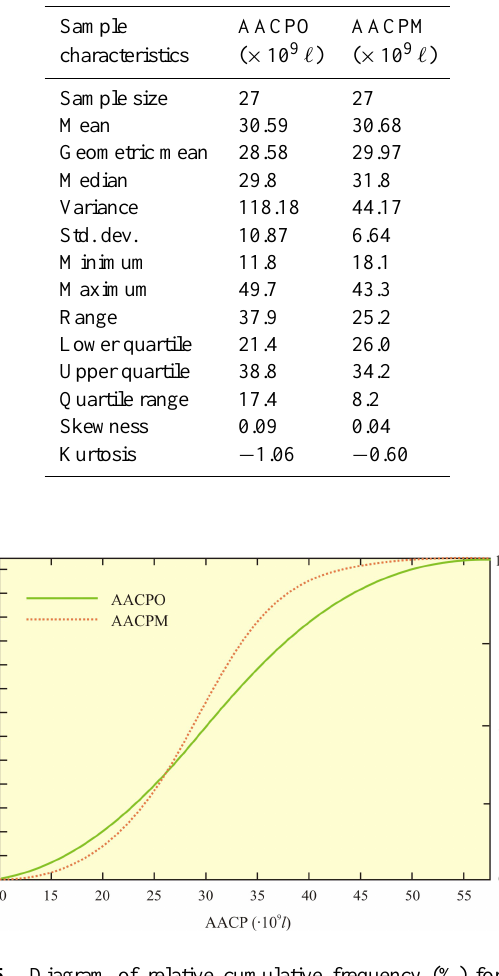
Fig. 5. Diagram of relative cumulative frequency (%) for data shown in Fig.